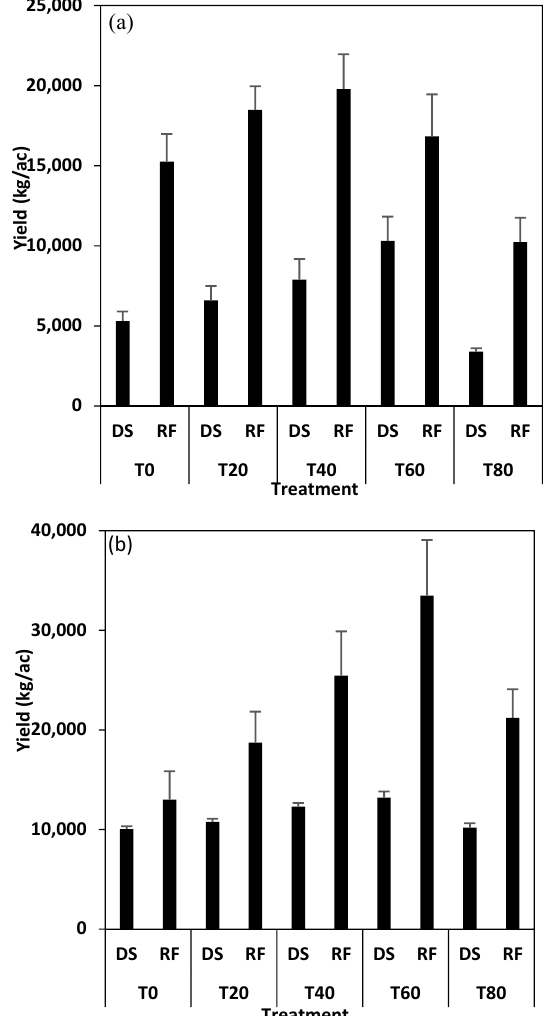
Figure 2. Average treatment yields (kilogram per acre) of ( a ) Amaranthus cruentus and ( b ) Solanum macrocarpon in the dry savanna ( DS ) and rainforest ( RF ) sites. T0 = 0 kg urea + manure treatment, T20 = 20 kg N + manure, T40 = 40 kg N + manure, T60 = 60 kg N + manure, T80 = 80 kg N + manure.